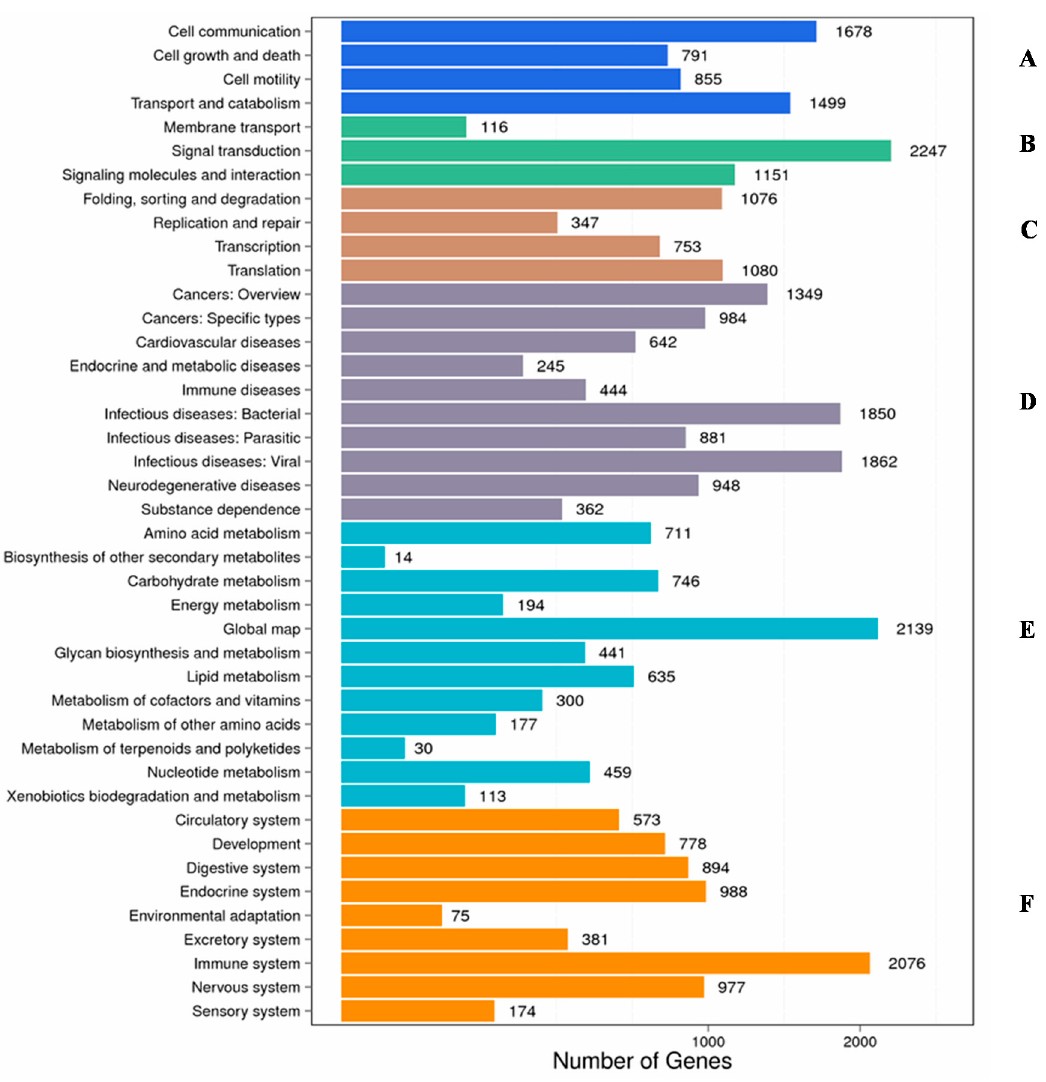
Figure 3. KEGG classification of assembled unigenes from control and treated groups. ( A ) Cellular processes; ( B ) Environmental information processing; ( C ) Genetic information processing; ( D ) Human diseases; ( E ) Metabolism; and ( F ) Organismal systems.